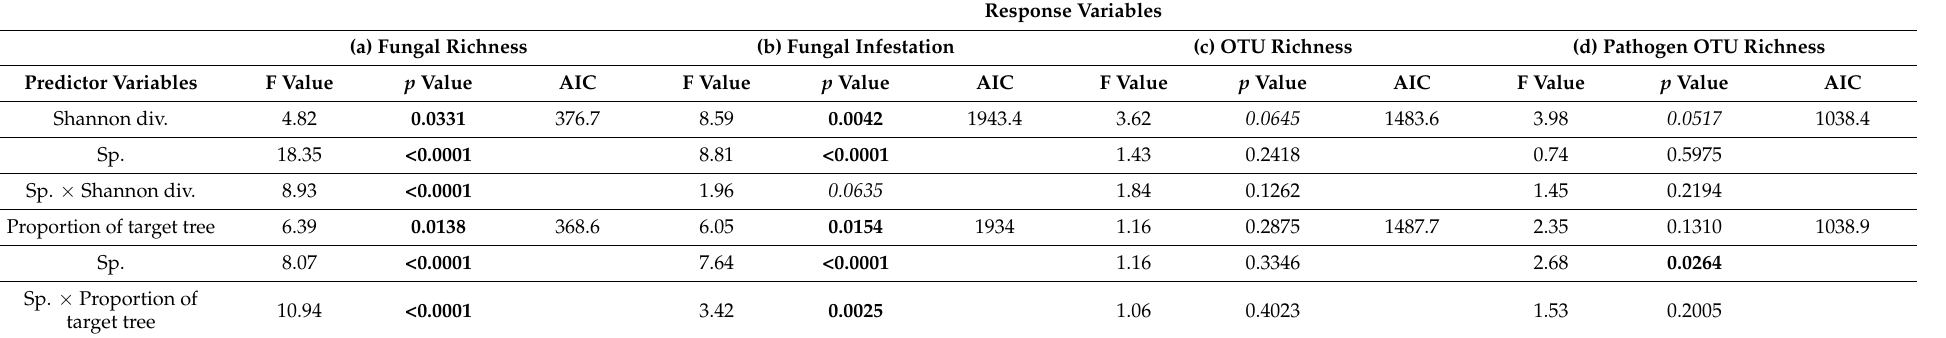
Table 1. Analysis of variance (ANOVA) table of the effects of Shannon diversity (Shannon div.) and proportion of the target tree in the local neighbourhood in interaction with species identity (Sp.) on (a) fungal richness, (b) fungal infestation, (c) operational taxonomic unit (OTU) richness and (d) pathogen OTU richness across all tree species. The results are based on linear mixed effects models with neighbourhood composition as random factor. Significant ( p < 0.05) and marginally significant ( p < 0.1) p values are indicated by bold and italic fonts, respectively.